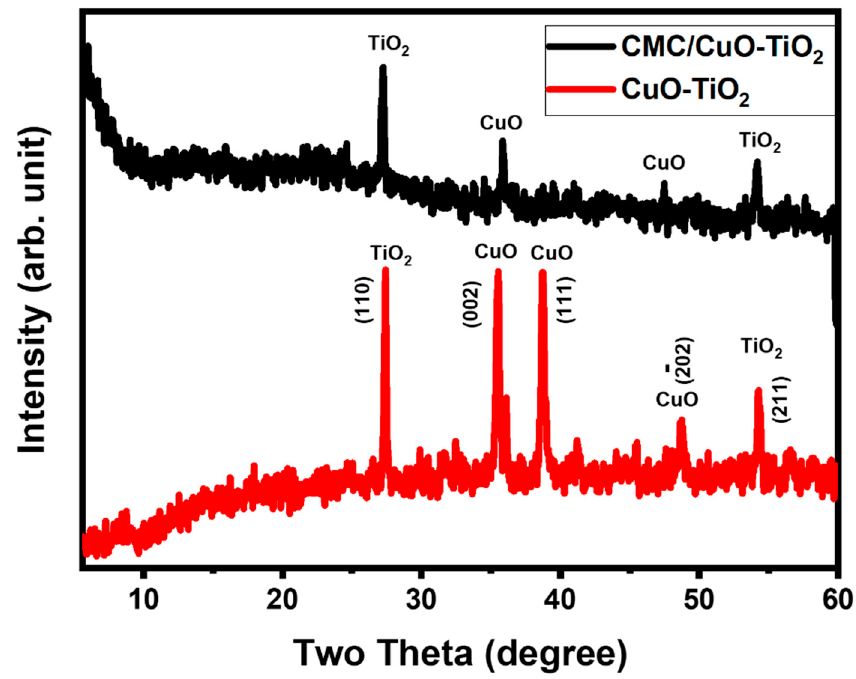
Figure 3. XRD pa tt ern of CuO-TiO 2 and CMC/CuO-TiO 2 . Figure 3. XRD pattern of CuO-TiO 2 and CMC/CuO-TiO 2